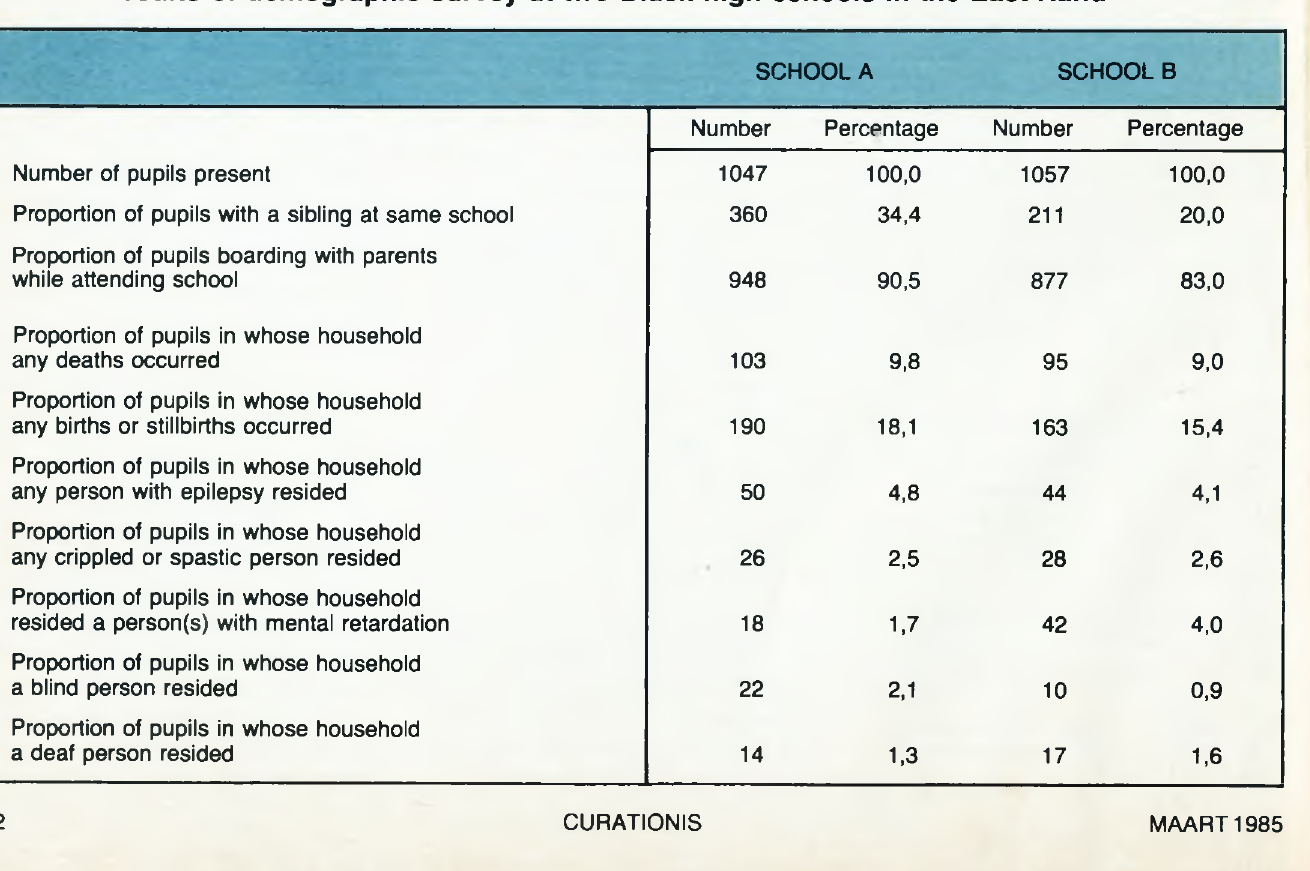
Table 1: Results of demographic survey at two Black high schools in the East